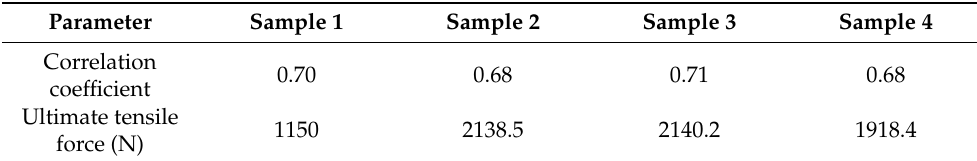
Table 2. Correlation coefficient and ultimate tensile force.